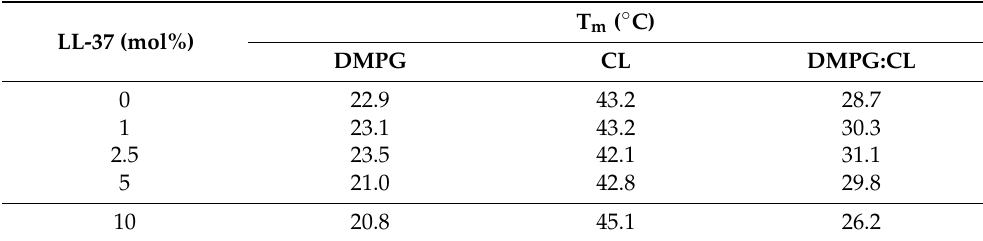
Table 2. Phase transition temperatures (T m ) of the three lipids systems in the presence of different concentrations of LL-37, as determined by FT-IR. Standard deviations are <0.1 ◦ C. LL-37